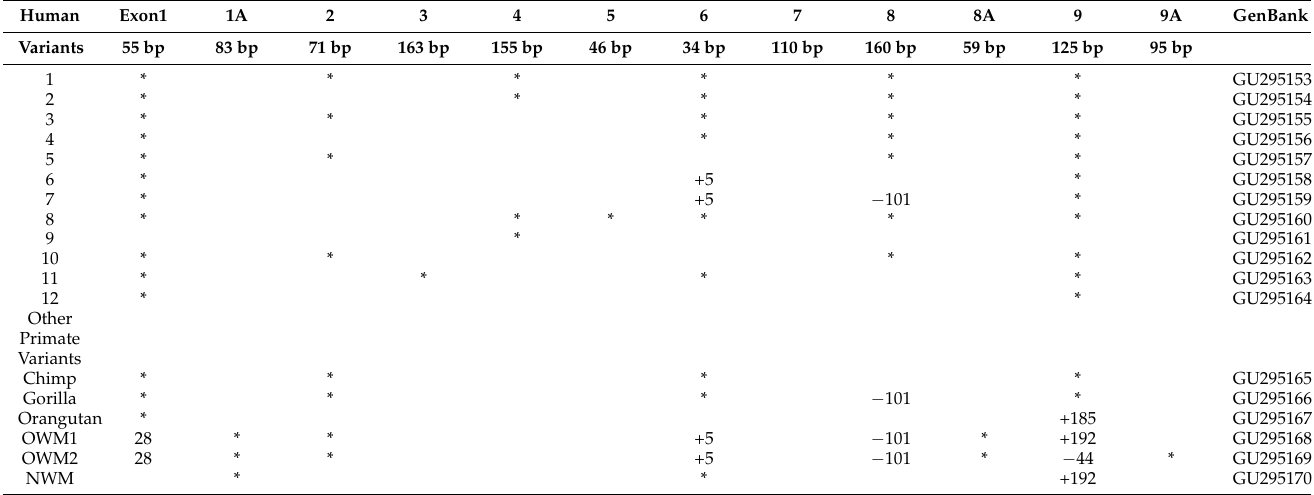
Table 1. Variant exon structure of TOSPEAK and its transcripts in human and primates. Exons included among alternatively spliced TOSPEAK transcripts are listed for multiple primate genera including Old World Monkey (OWM) & New World Monkey (NWM). * Indicates the